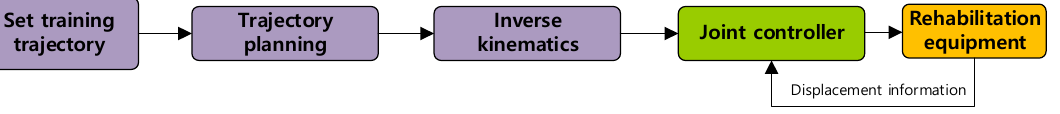
Figure 7. System control diagram of the passive training mode.